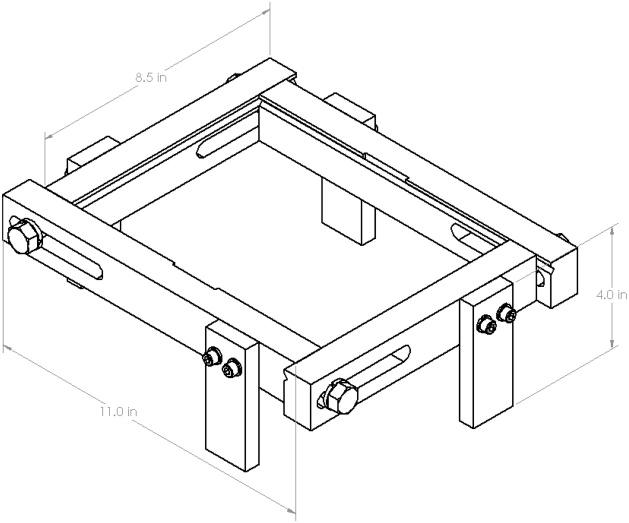
Sample frame design.